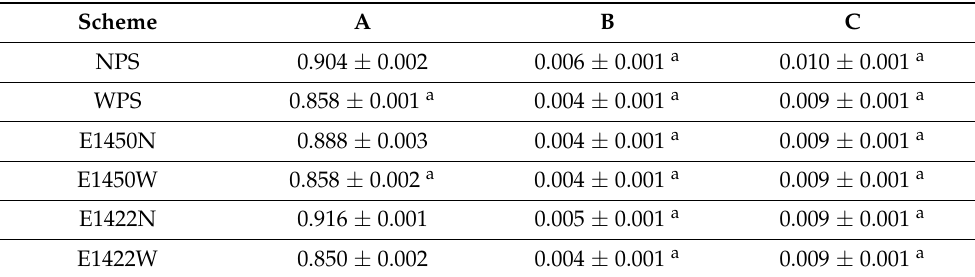
Table 1. Parameters characterizing the dependence of the equilibrium water activity as a function of